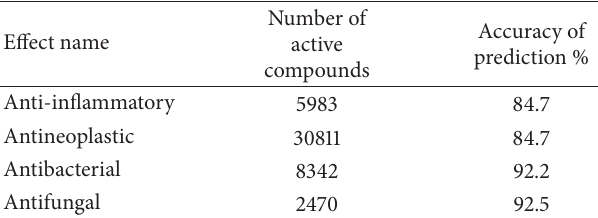
Table 2: List of pharmacological effects projected for natural compounds by